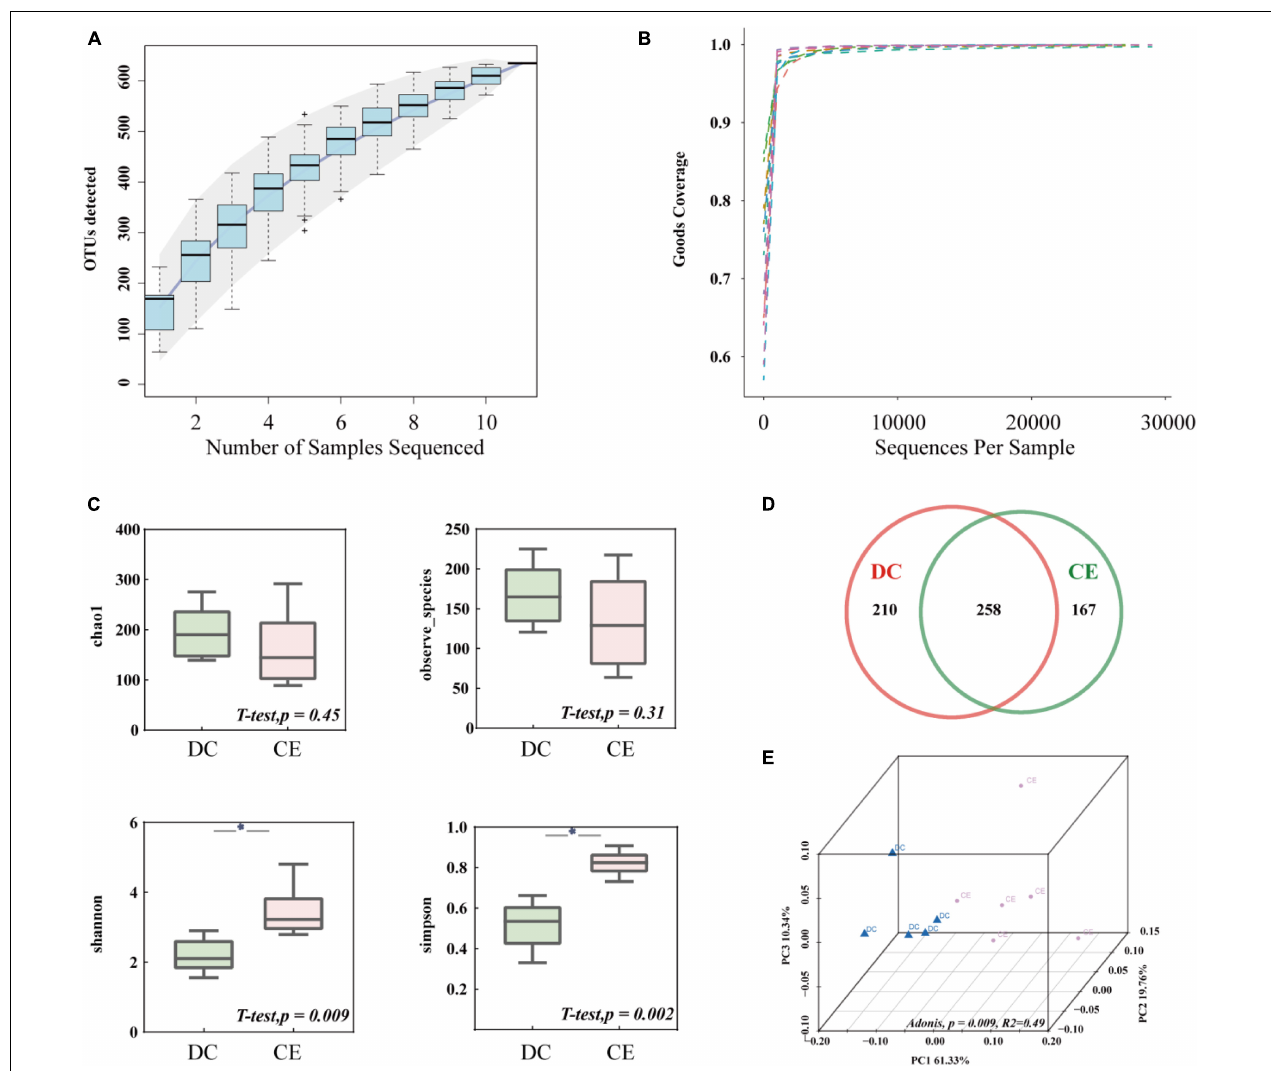
FIGURE 2 | The microbial community structure in the ileum was significantly altered by adding CE ( n = 6 hens/group). (A) Species accumulation curve is used to estimate the rationality of sequencing sample quantity. (B) Alpha diversity Rarefaction curve based on Good’s Coverage value, which reflects the rationale of sequencing depth. (C) Alpha-diversity evaluation of ileum microbial richness and evenness by measuring chao1, observe-species, Shannon, and Simpson’s diversity indexes. (D) Venn diagram is used to represent the amount of shared and unique OTUs numbers. (E) Principal coordinate analysis (PCoA) is used to determine the similarities of microbial communities between different groups. * P < 0.05 compared to two